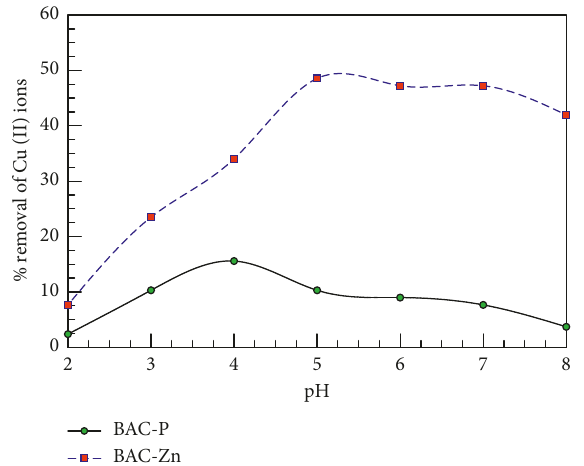
Figure 15: Pseudo-first-order kinetics for adsorption of 1g L − 1 Figure 13: Effect of pH on the removal efficiency of Cu(II) ions � 1g L − 1 , agitation speed � 150rpm, Cu(II) ions onto the BAC-P and BAC-Zn adsorbents. using BAC-P and BAC-Zn at c 0 dose of each adsorbent � 1g, contact time � 300min, particle size � 250 µ m, and temperature of solution � 30 ° C.